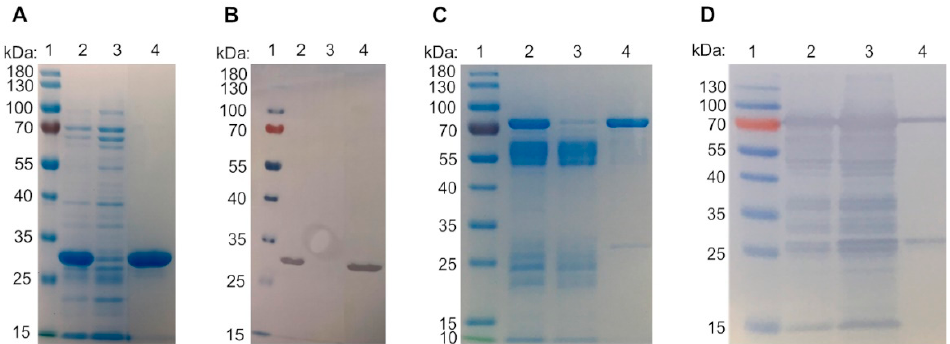
Figure 2. Electrophoretic analysis of Gal-3 proteins purified by IMAC and ASF affinity chromatography. ( A ) SDS-PAGE HGal-3 (28 kDa); ( B ) Western blot of HGal-3 ( C ) SDS-PAGE of HSYGal-3 (74 kDa); ( D ) Western blot of HSYGal-3. 1: Protein standard (10–180 kDa); 2: IMAC eluate; 3: Wash fractions collected in ASF affinity chromatography; 4: Eluate of ASF purification. Protein bands of SDS-PAGE were visualized by Coomassie staining. Western blot was performed with a primary anti-Gal-3-antibody and a secondary peroxidase-conjugated